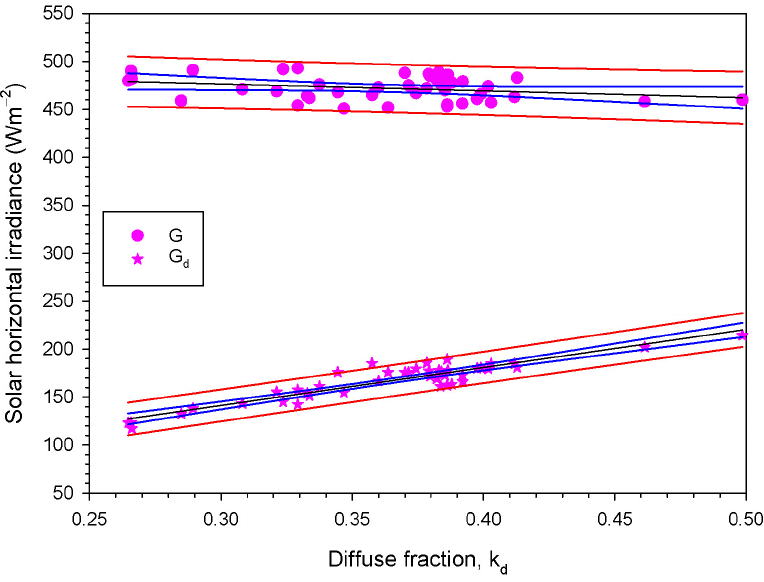
Figure 7. Scatter plot of the annual mean values of G (circles) and G d (stars) for the 43 sites as a function of their diffuse fraction, k d , under all-sky conditions in Saudi Arabia for the period 2013–2021. The black solid lines are linear fits to all data points irrespective of their SEZ, with equations G = − 172.1414k d + 522.0128, with RMSE = 18.5156 Wm − 2 , MAE = 14.1101 Wm − 2 , d = 0.4390, r = 0.4044, an R 2 = 0.1635; and G d = 396.0899k d + 22.4648, with RMSE = 7.7729 Wm − 2 , MAE = 6.0168 Wm − 2 , d = 0.9590, r = 0.9244, and R 2 = 0.8545. The blue bands represent the ±95% con fi dence intervals, and the red ones represent the ±95% prediction intervals. The plot was made with the SYSTAT’s SigmaPlot 14.0.0.124 graphing software, and the statistical results were computed with the MICROSOFT’s Ex- cel 2021 functions.